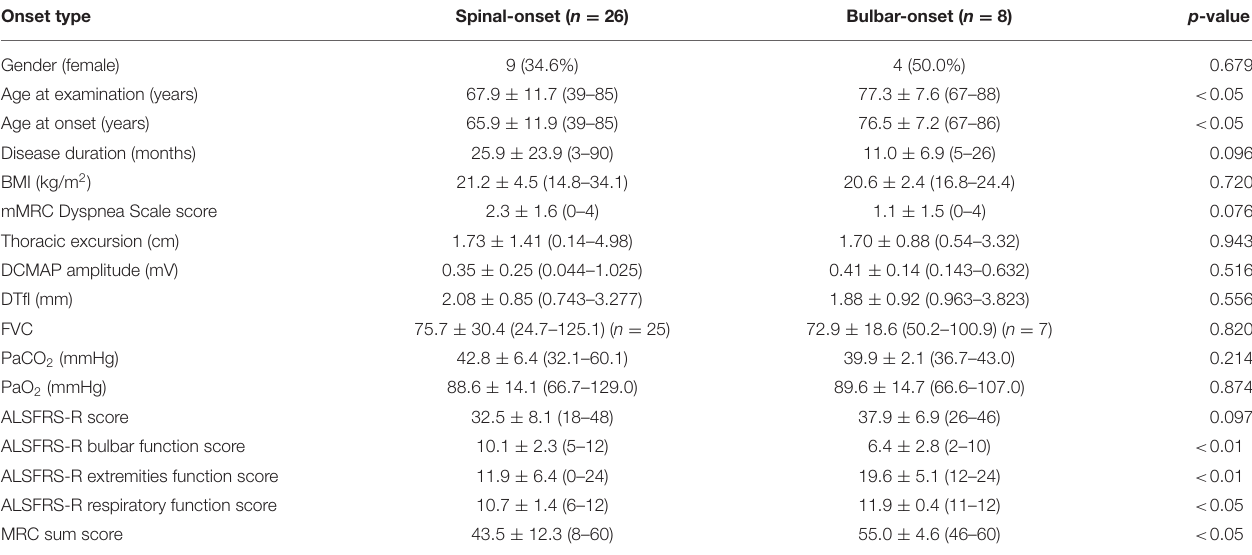
TABLE 2 | Demographic characteristics of patients with spinal-onset and bulbar-onset ALS. Onset type